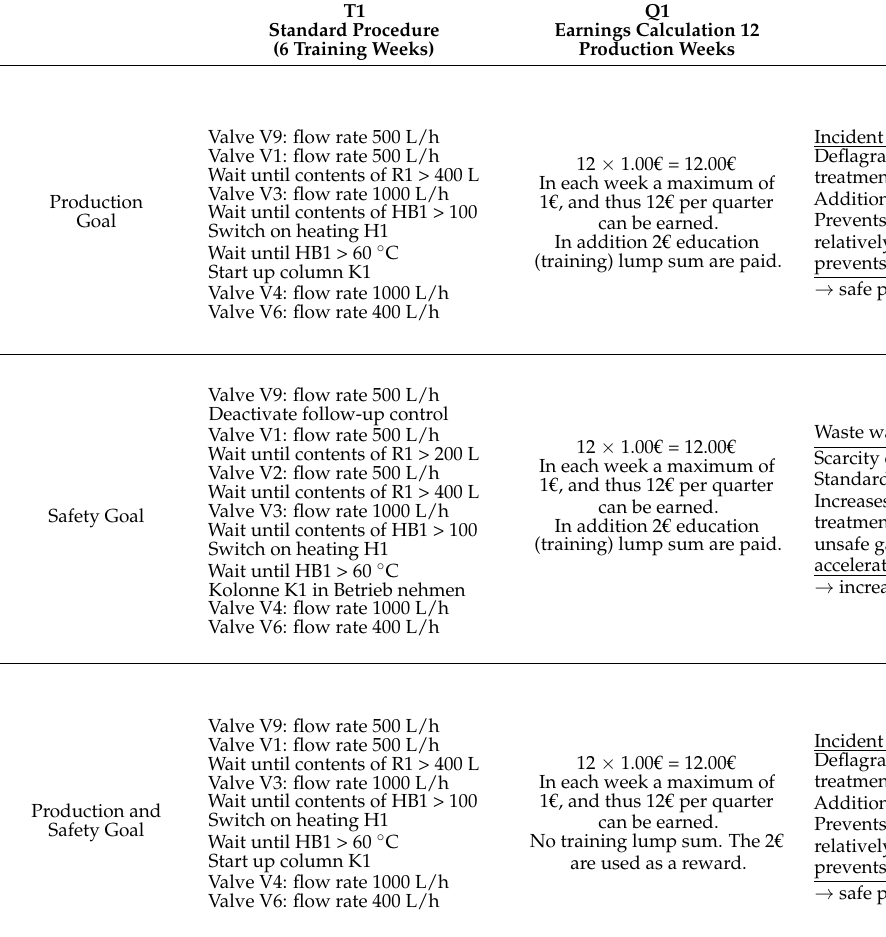
Table 1. Overview table for operationalization of the goal conditions and its implications for procedures (to be executed in WaTrSim) used and